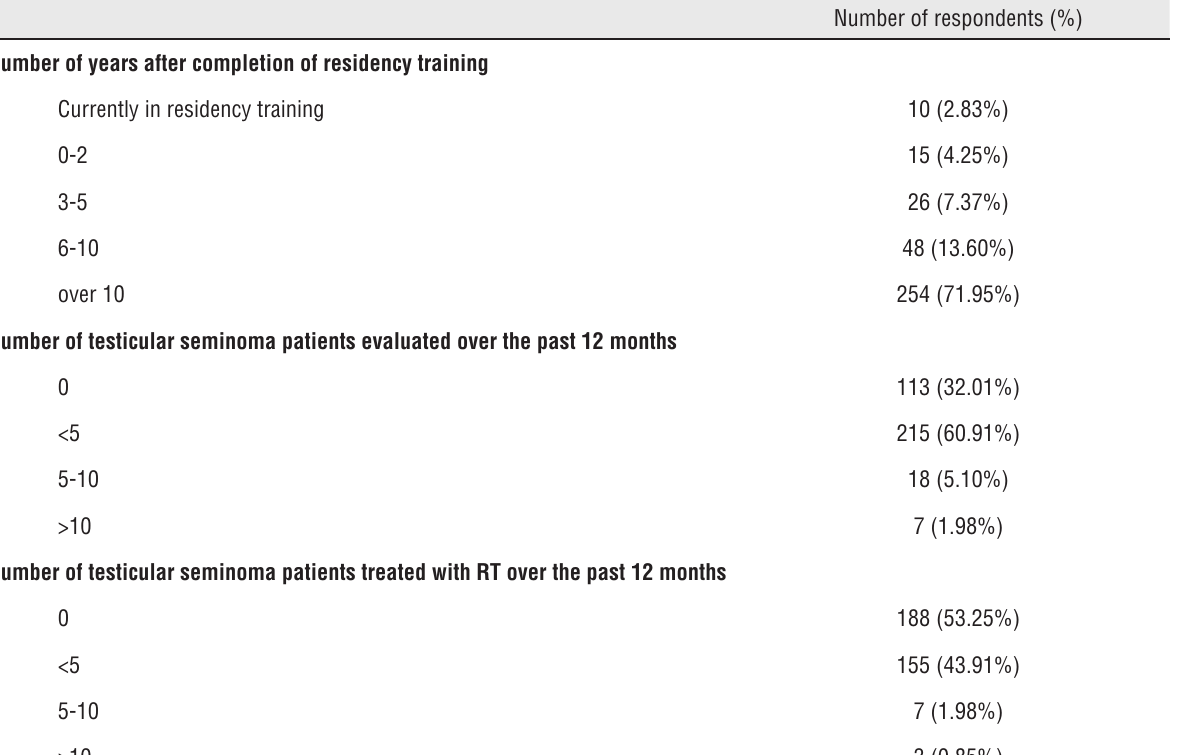
Table 1 - characteristics of radiation oncologists who completed the